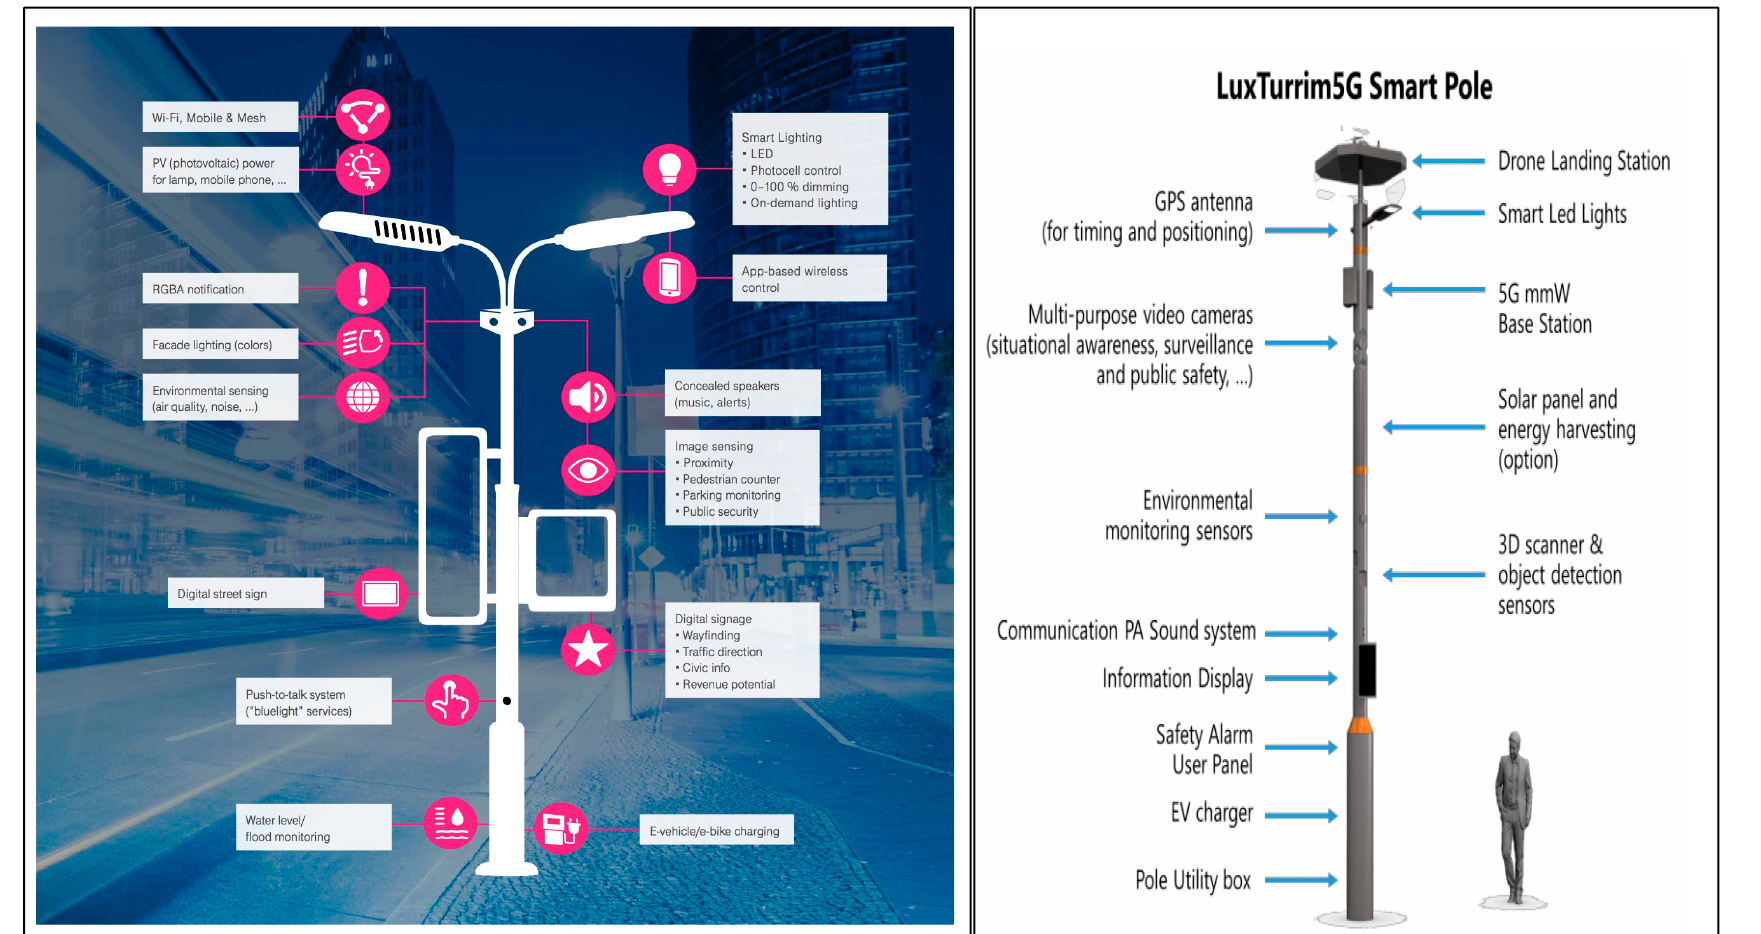
Figure 7. Smart Street Lighting models developed by Deutsche Telekom and Nokia, derived from [151,152].